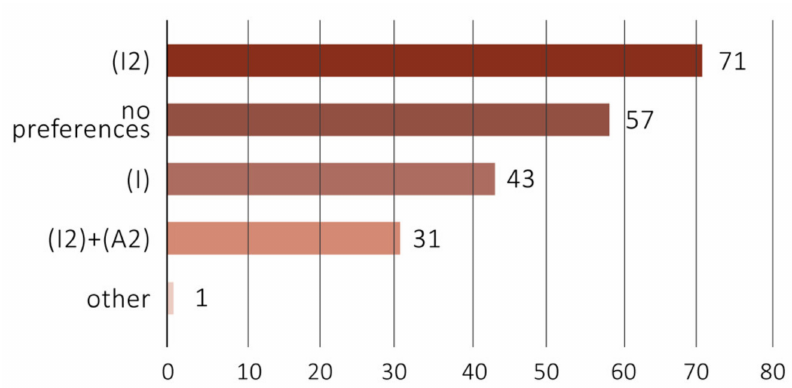
Figure 5. Frequencies concerning the users’ preferences among the different kinds of thermoscanners (I1,I2,I3). Own